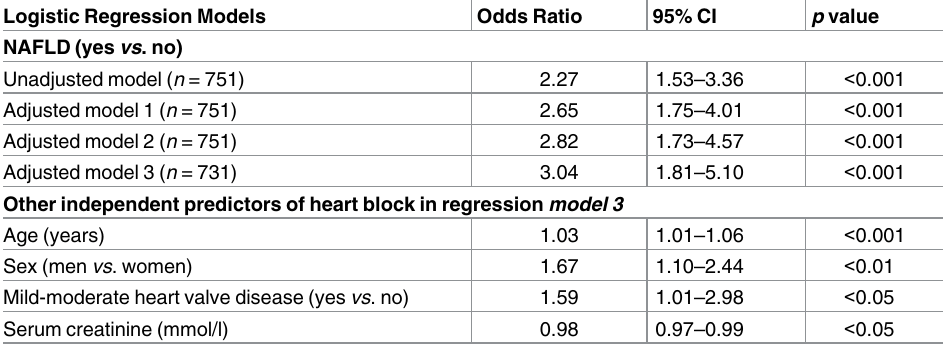
Table 2. Logistic regression models—Association between NAFLD and the risk of prevalent heart block in patients with T2DM. Logistic Regression